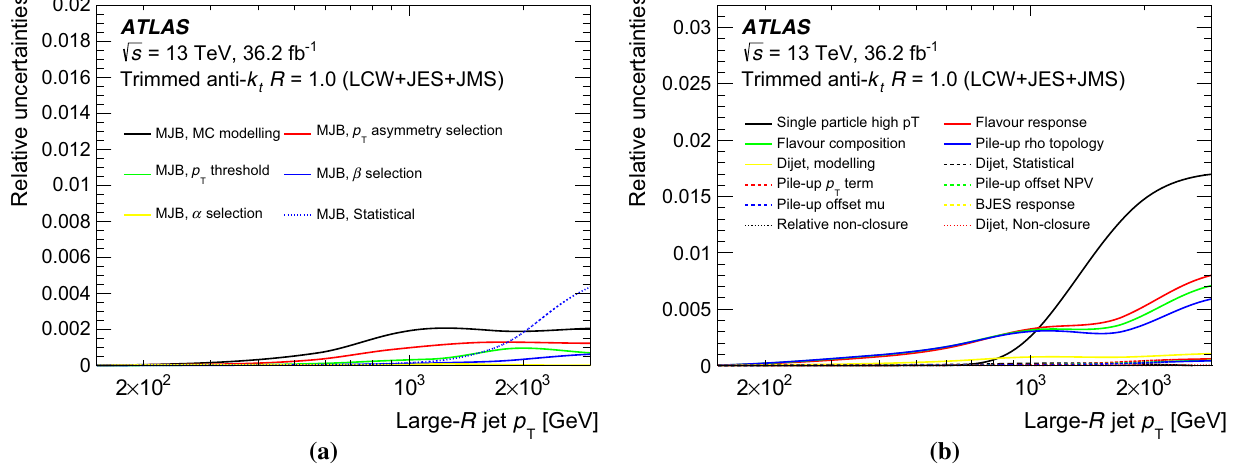
Fig. 29 Breakdown of the combined uncertainty in the large- R jet p T response as a function of the jet transverse momentum p T . Contribu- tions are shown for nuisance parameters of the multijet balance method for nuisance parameters a originating from the MJB selection and b propagated from the small- R jets which constitute the recoil system. The vertical axis reflects the uncertainty introduced by a given nuisance removes spikes due to statistical fluctuations in the measure- ments, as well as discontinuities at the first and last point in a given